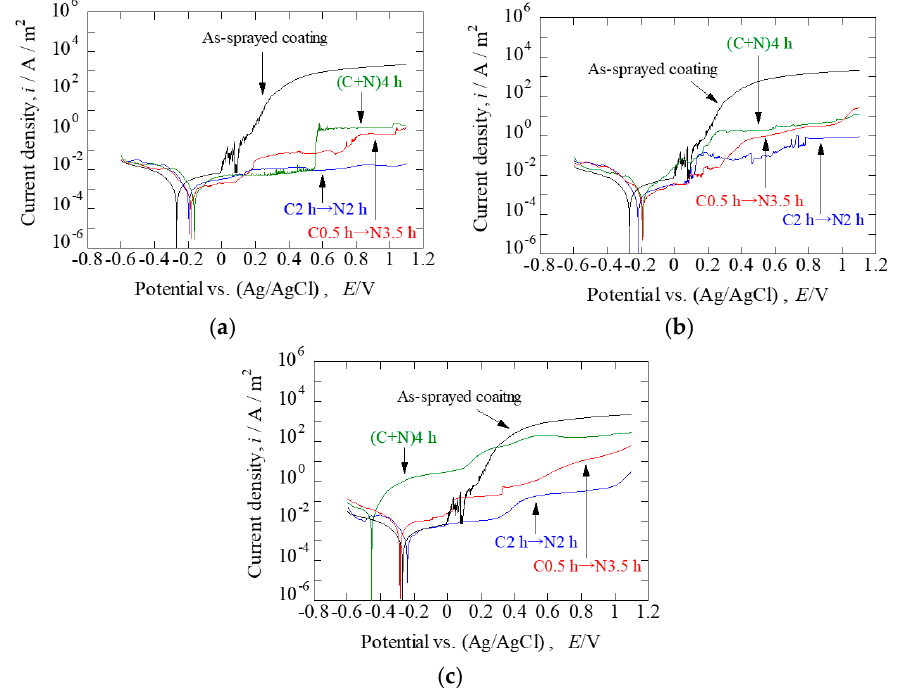
Figure 12. Anodic polarization curves in 3.5 wt % NaCl solution of S-phase layers on cold-sprayed AISI 316L coatings obtained by (C0.5 h → N3.5 h), (C2 h → N2 h) and ((C+N)4 h) at ( a ) 400 °C, ( b ) 425 °C and ( c ) 450 °C.